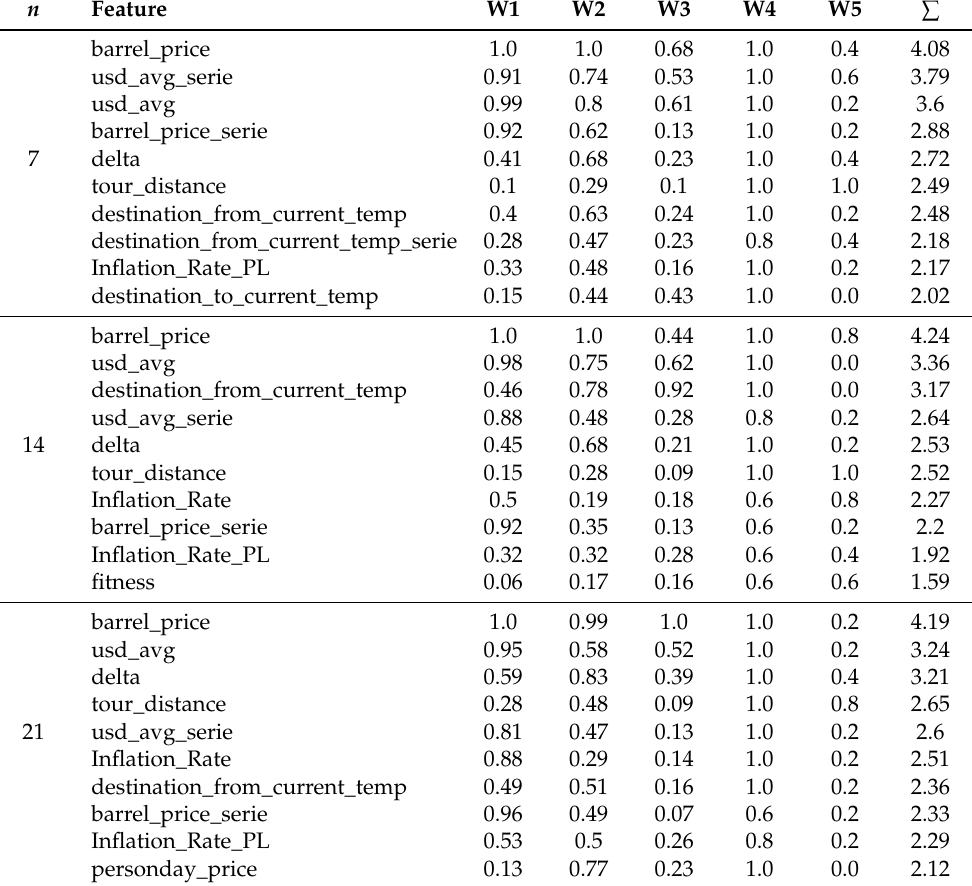
Table A3. Results obtained for top 10 features identified in each classification problem for trips with own